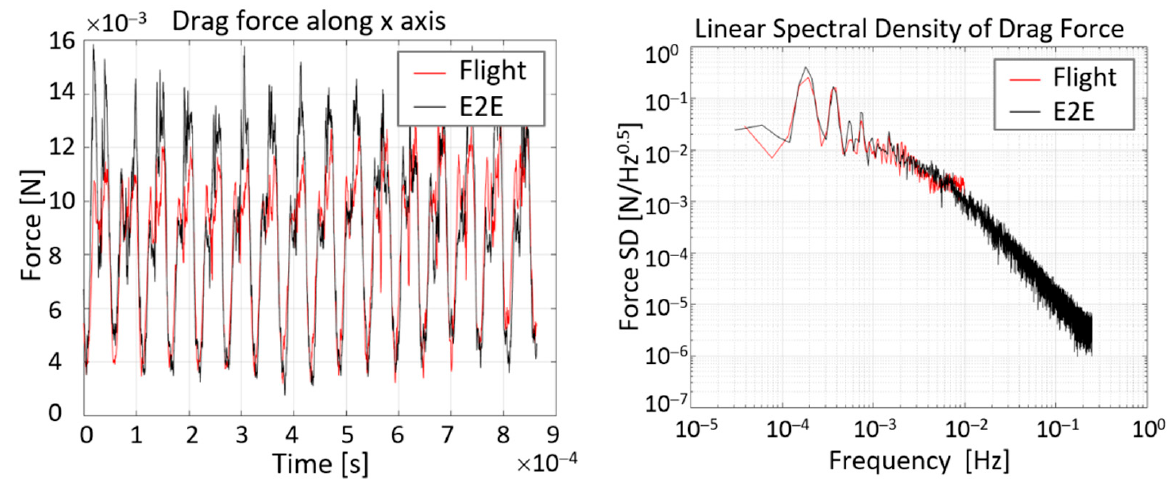
Figure 12. Time history and amplitude spectral density of the drag force along the X-axis of GOCE measured in flight (black line) and computed by the E2E simulator (red line).